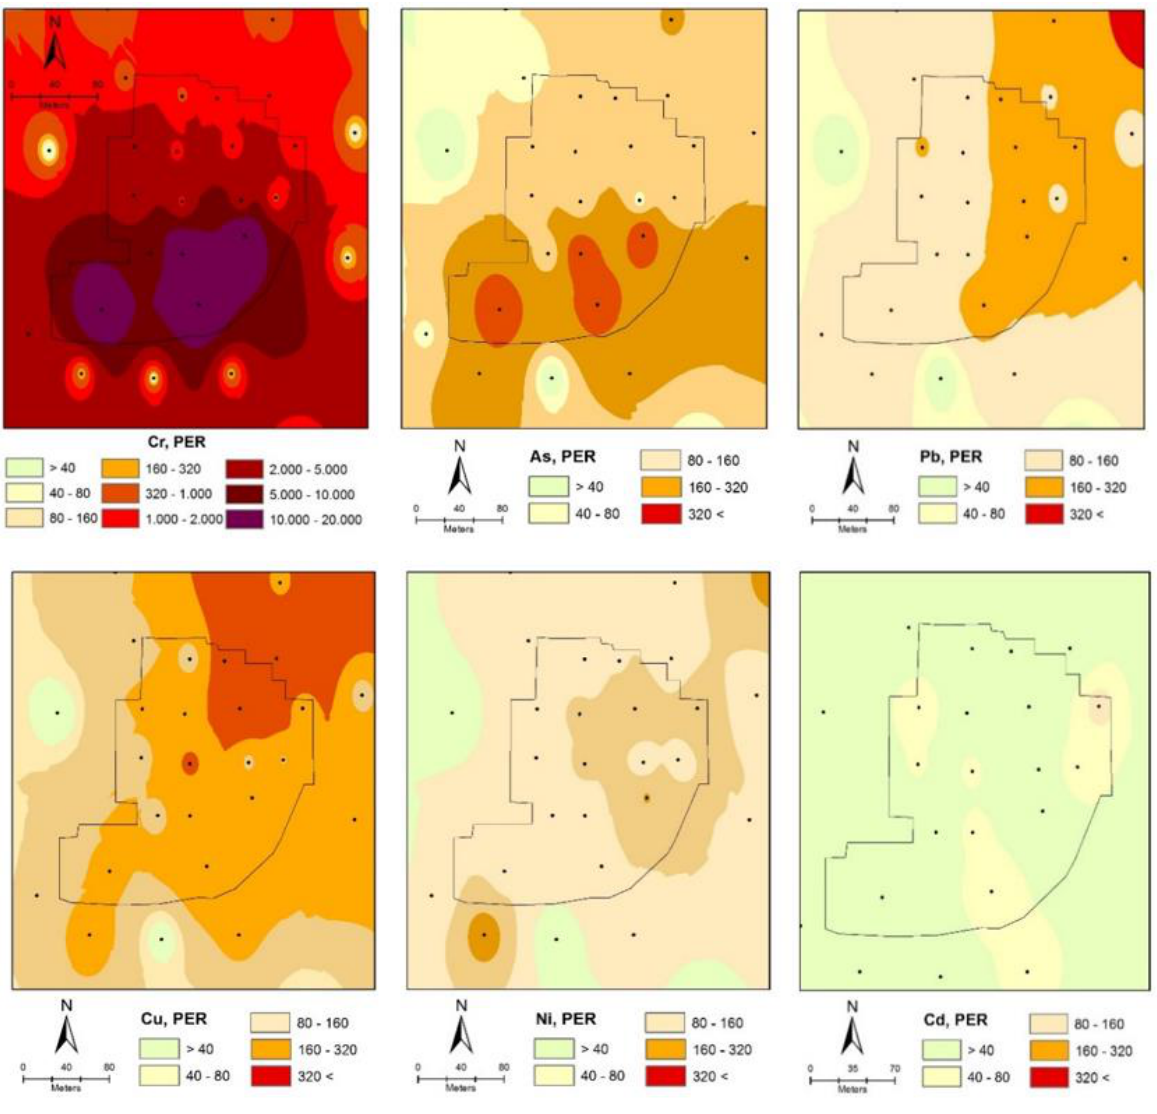
Figure 4 . Spatial distribution of soil heavy metal PER coefficient of WWTP and a leather processing factory area of Ulaanbaatar. The spatial distribution characteristics of PER are indicated by green, yellow and red in each map. The brown, red and orange show high ecological risk, yellow and green show a low ecological